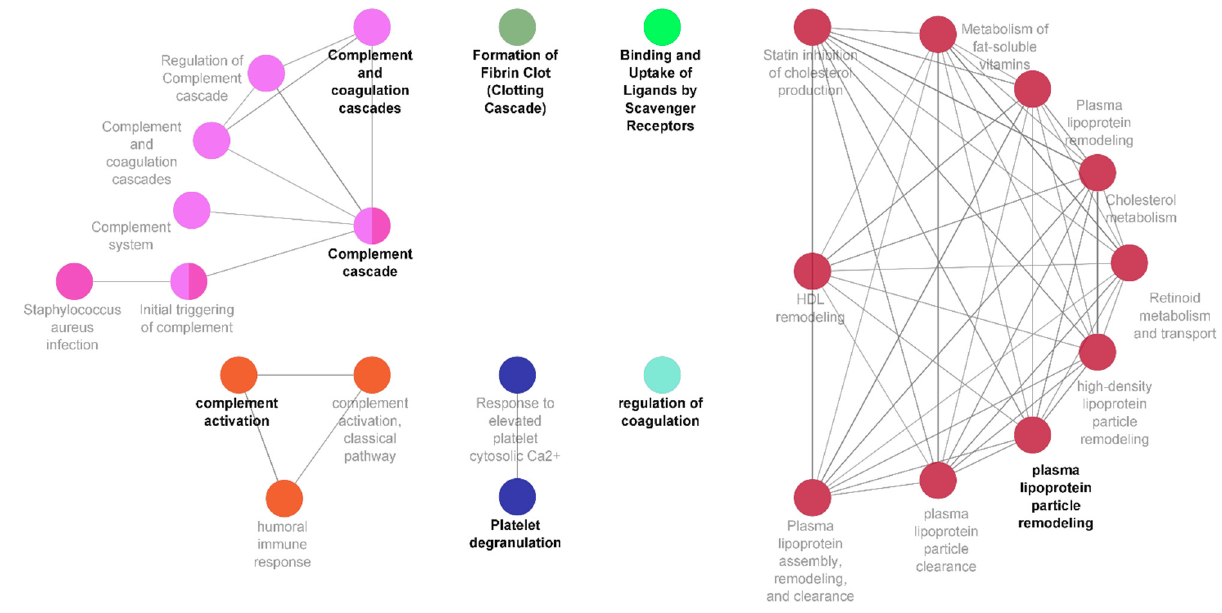
Figure 3. Complement and coagulation cascades characterise newly diagnosed prostate cancer patients alongside regulation of coagulation, clotting cascade, ligand binding and uptake, and plasma lipoprotein particle remodelling. Network representation of specific functional clusters created using the ClueGO application within Cytoscape, derived from those proteins showing statistically significant differences between the PCa and HC classes. Identified proteins associated to these pathways are detailed in Table S3.